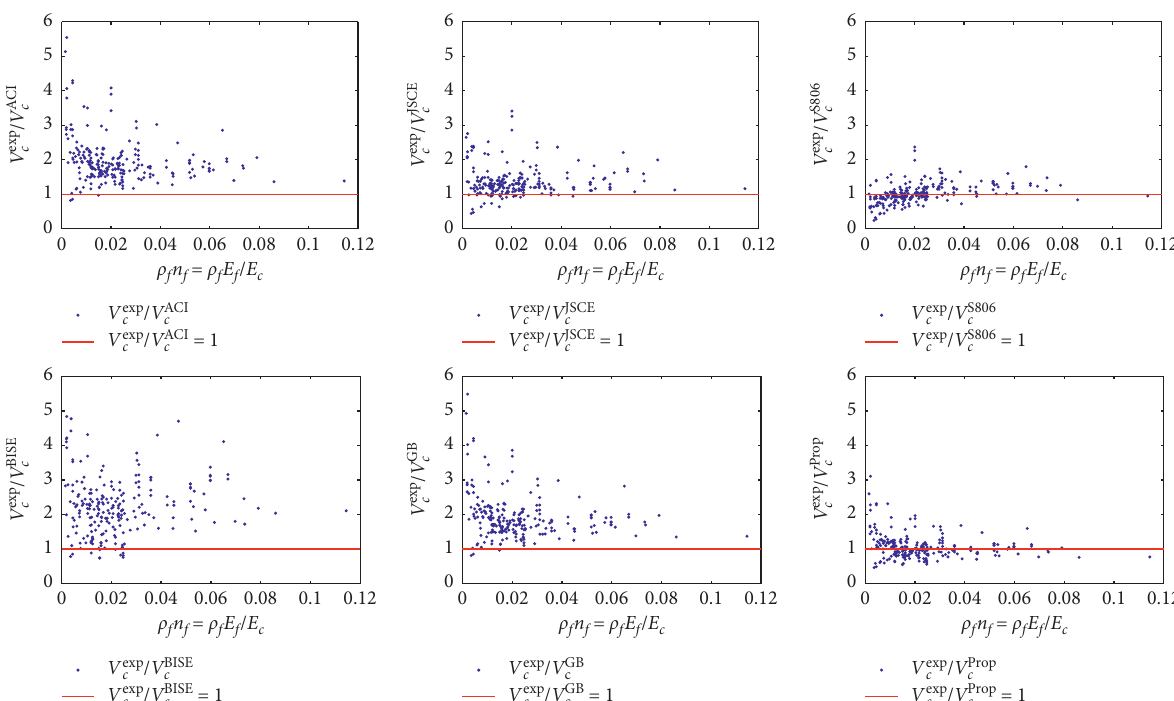
Figure 7: Comparison of ( V exp